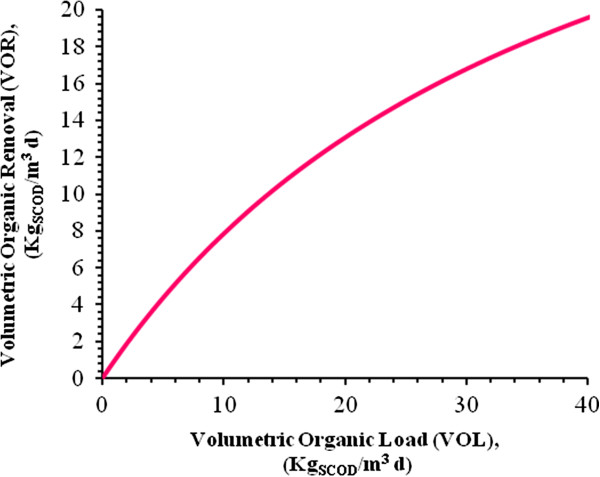
Organic loading of the bioreactor in the range of 0 to 40KgSCOD/m3d at 32°C.